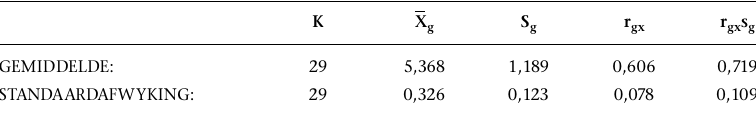
0,109. Die 29 items van Skaal 1 het volgens Cronbach se alfa- koëffisiënt, ’n betroubaarheid van 0,937 opgelewer. Dit blyk uit die ontleding dat Skaal 1 hoogs aanvaarbare metriese eienskappe toon. Tydens die itemontleding van die 16 items van Skaal 2